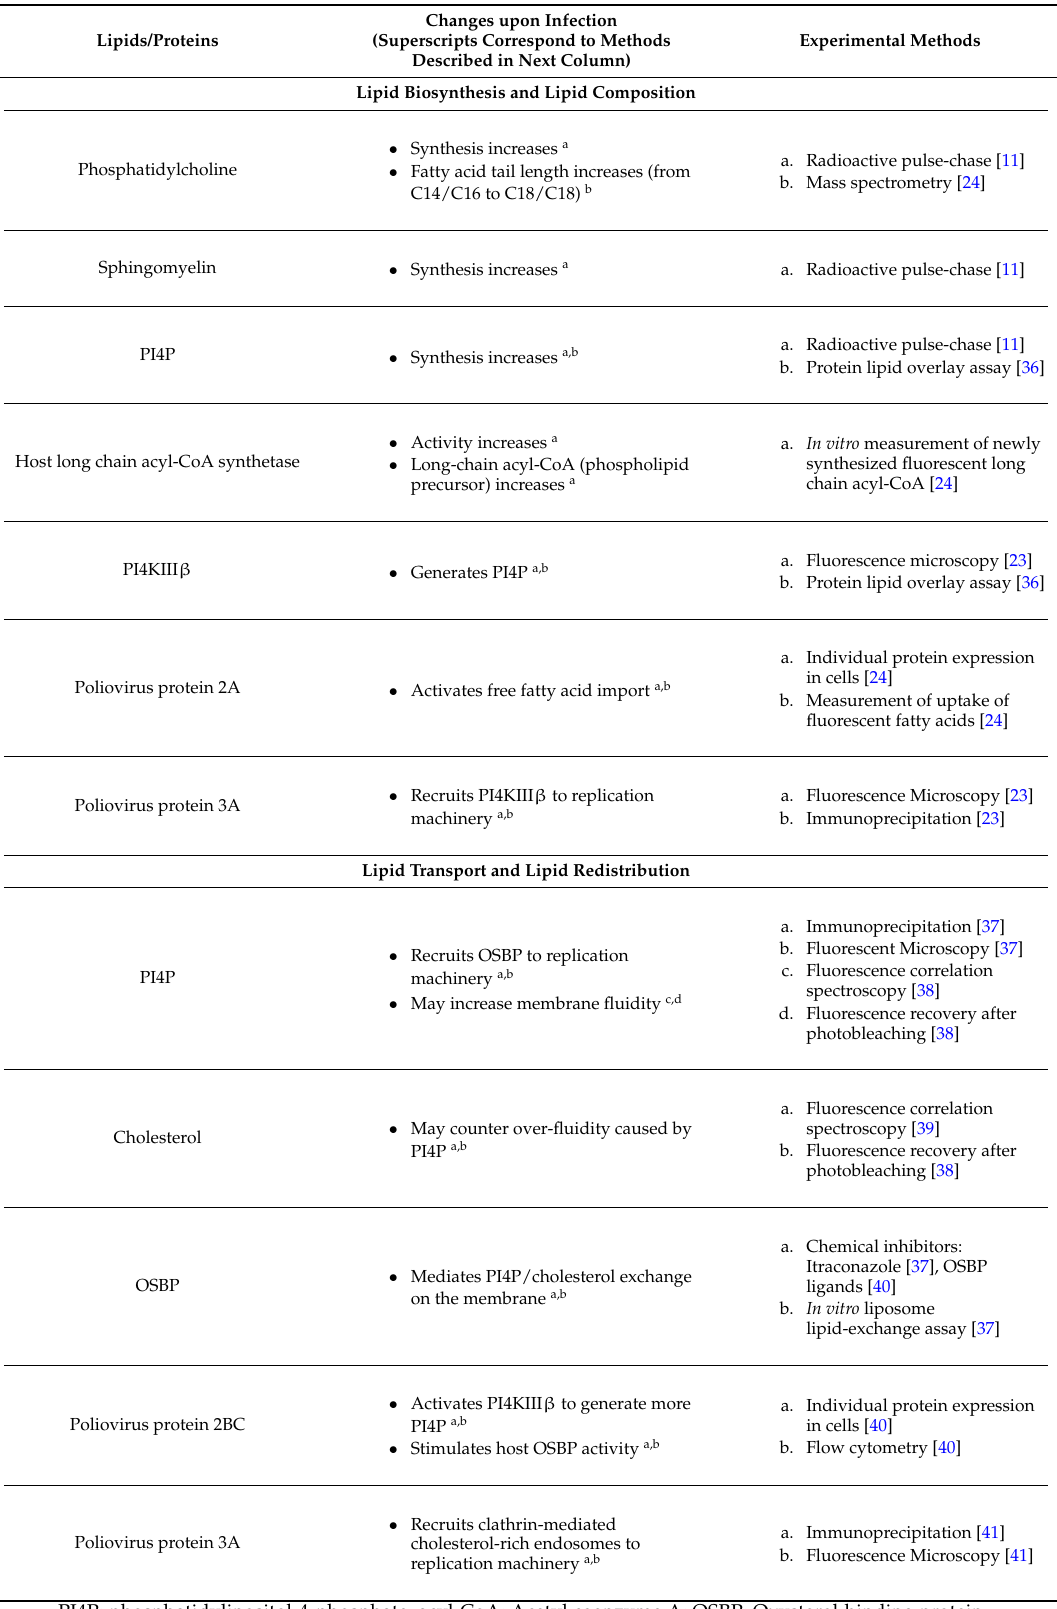
Table 1. Poliovirus induced alterations in lipids and proteins. Changes upon Infection Lipids/Proteins (Superscripts Correspond to Methods Described in Next